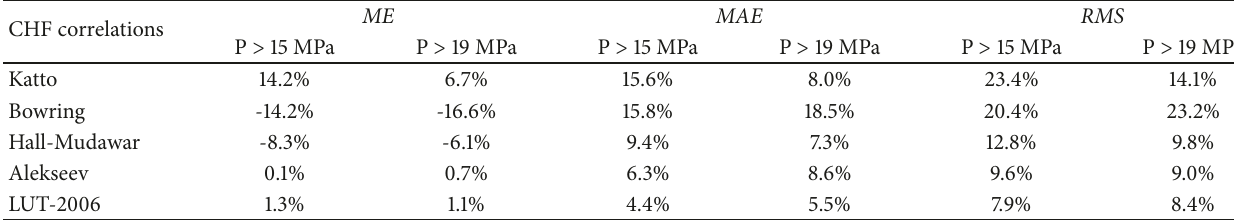
Table 4: Prediction error of each CHF